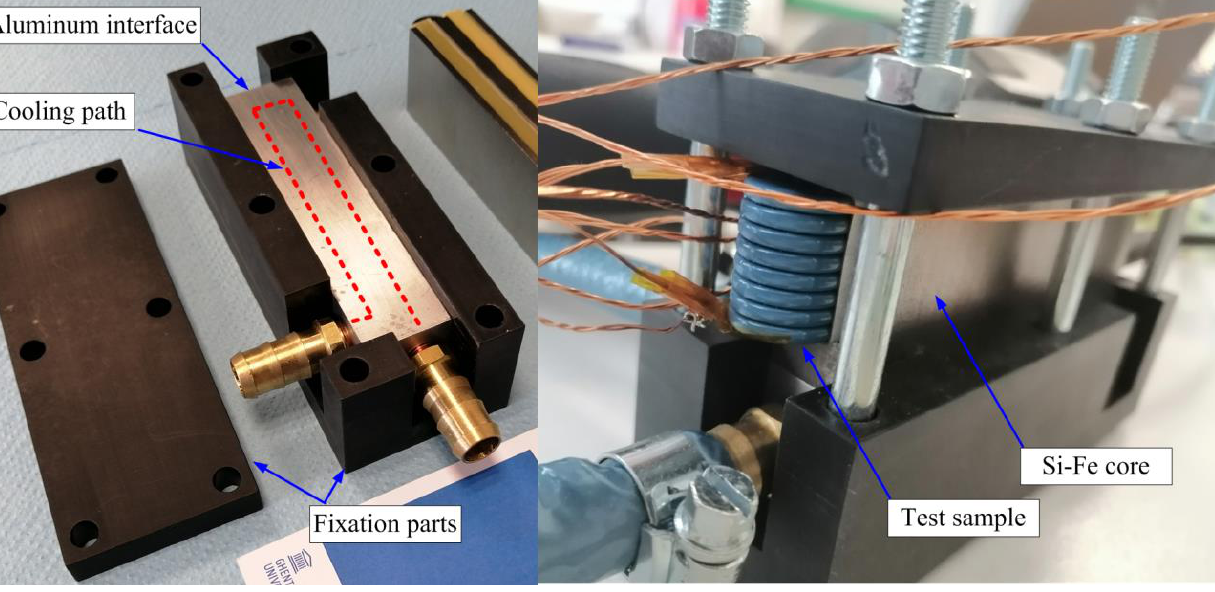
Figure A2. Weight comparison between 3D printed copper and aluminum coils.